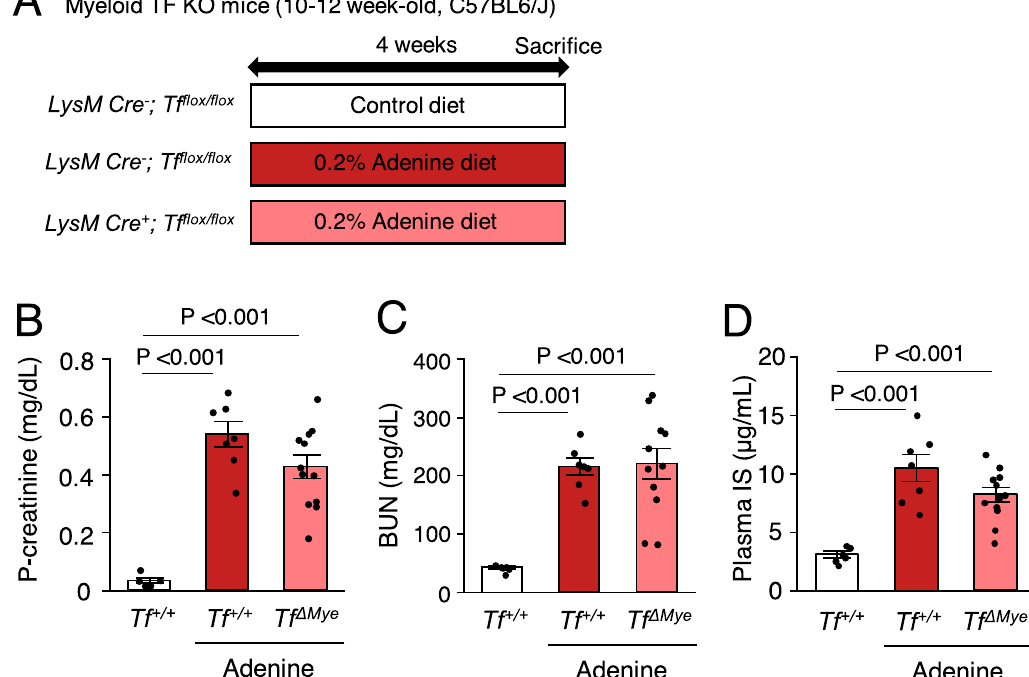
Figure 4. Levels of plasma creatinine, BUN, and IS in adenine-induced nephrotoxicity. ( A ) An experimental protocol for the diet administered to the animals in this study. TF, tissue factor. KO, knockout. ( B–D ) Comparison of the plasma creatinine (P-creatinine), blood urea nitrogen (BUN), and plasma indoxyl sulfate (IS) levels among groups. n = 6–12. Data are shown as the mean ±